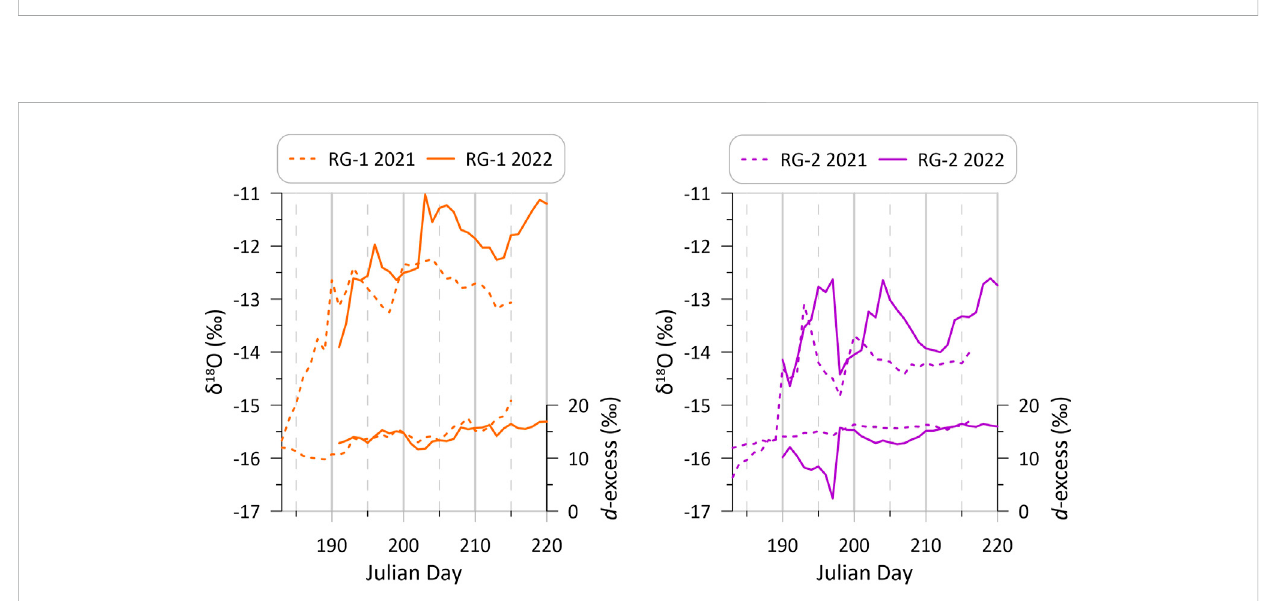
FIGURE 9 Time series of δ 18 O and d -excess through the melt seasons of 2021 (Munroe and Handwerger, 2022) and 2022 at RG-1 and RG-2 in the Uinta Mountains illustrating the general constancy of the pattern of rising values over multiple years.